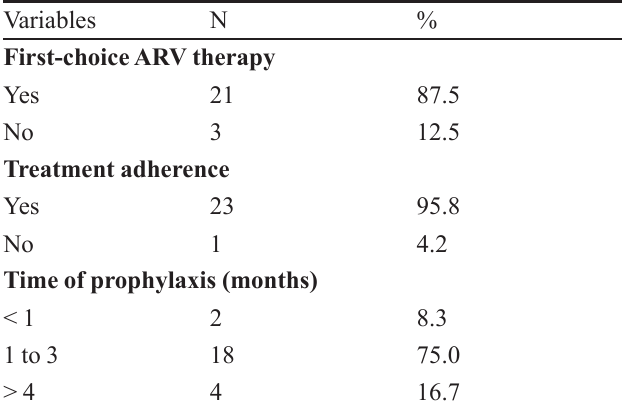
TABLE IV - Distribution of patients carrying human immuno- deficiency virus (HIV) according to use of first-choice anti- retroviral (ARV) therapy, treatment adherence, and time of prophylaxis (n=24) (DHGMM, 2007) Variables N